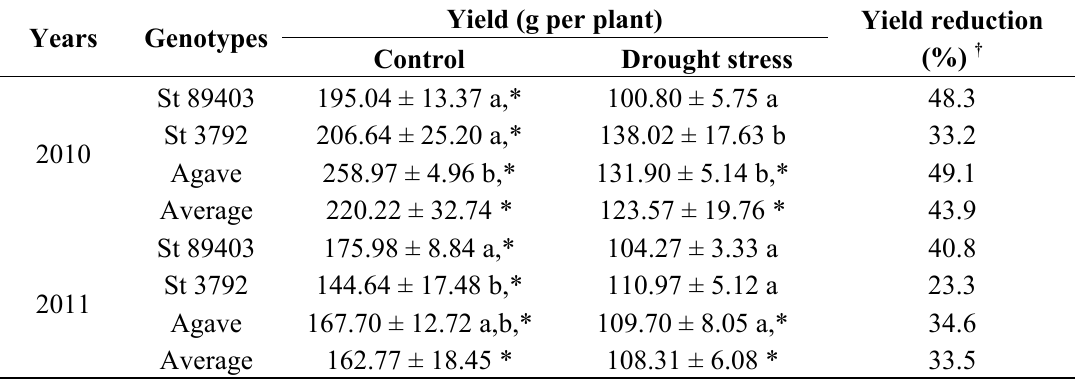
Table 2. Tuber yield of control and drought stressed plants and reduction of yield caused by drought stress (Mean ± SD; n =